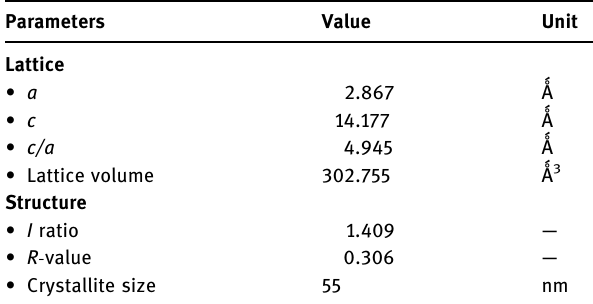
Table 2: Lattice parameter and structural parameter of the as - pre